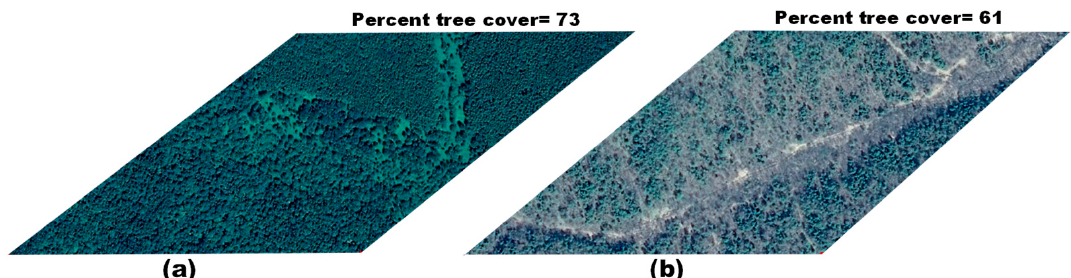
Figure 13. Two typical MODIS pixels with tree coverage greater than 60% and CI obtained from these two pixels were used as comparative data for GLAS CI. ( a ) is a MODIS pixel with tree coverage of 73%; ( b ) is a MODIS pixel with tree coverage of 61%. It can be noted that there are elements such as grass and bare land in these pixels in addition to trees.